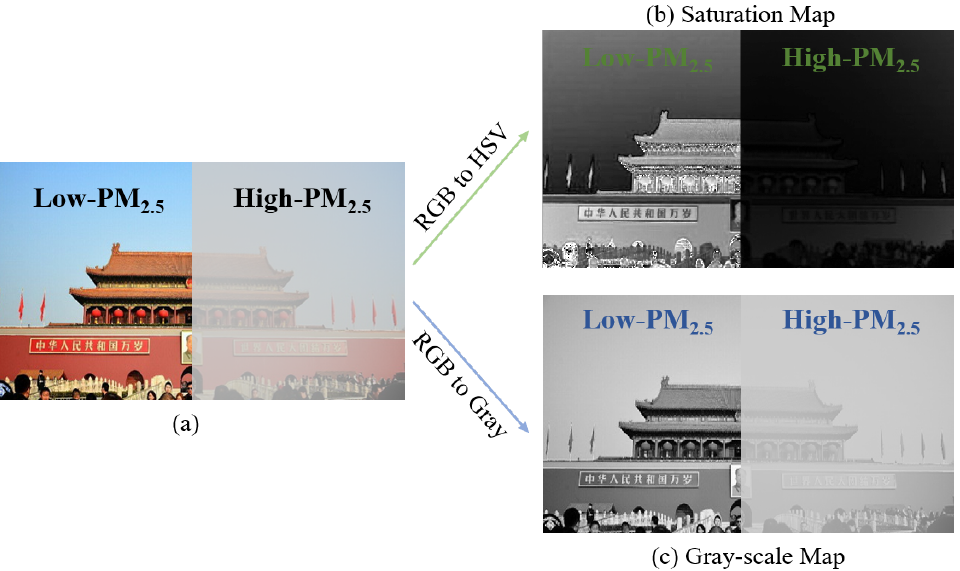
Figure 2. Comparisons of saturation and grayscale channels in photos collected under good and bad weather. ( a ) A mixed sample image. ( b , c ) The saturation and grayscale channels of ( a